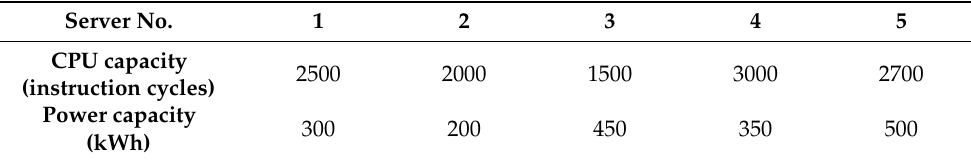
Table 2. Server configuration.